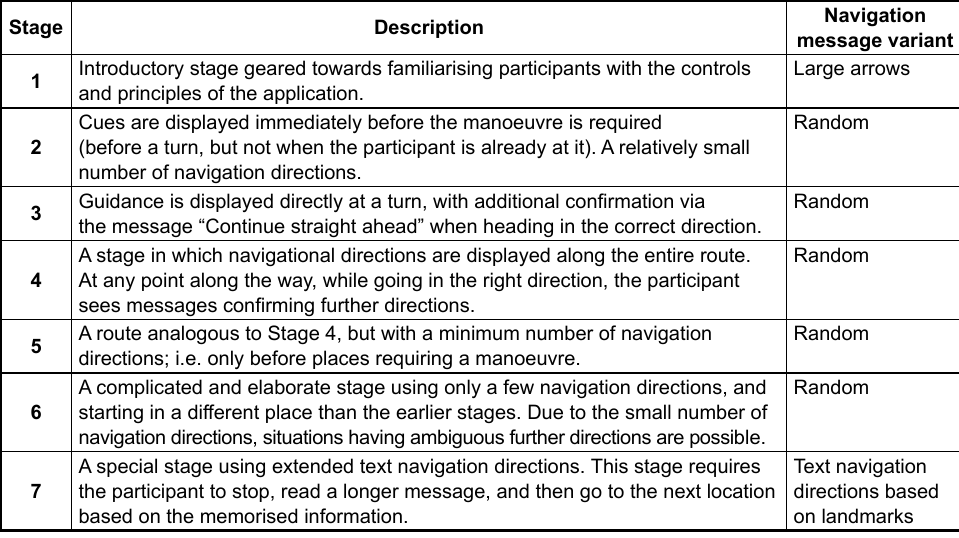
Table 1. Description of the implemented stages and the navigation message variants